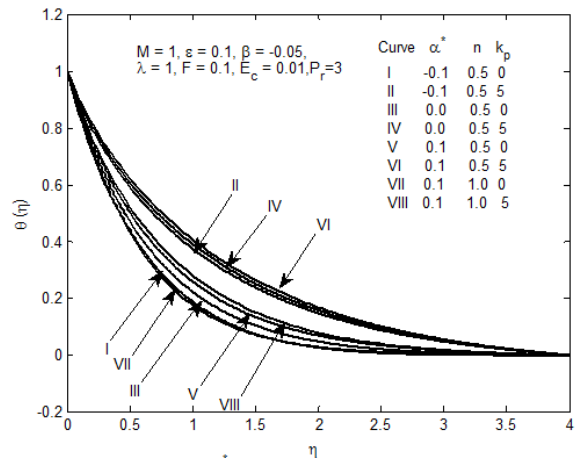
Figure 10: Temperature profiles (PST case)